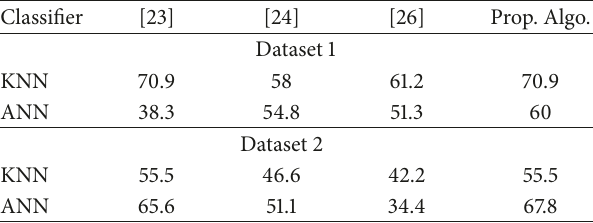
Table 4: Accuracy for 85 and 15 percent training and testing data. Classifier